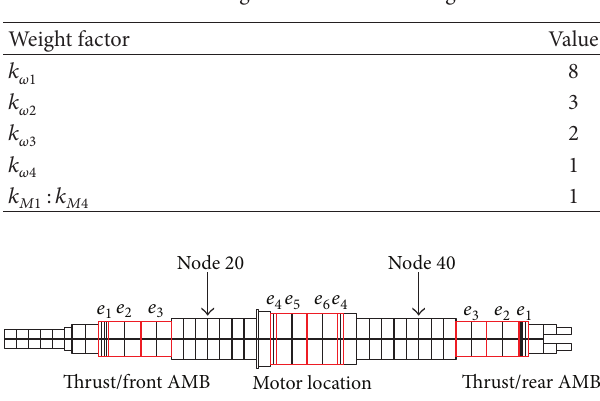
Table 5: Weight factors for error targets.